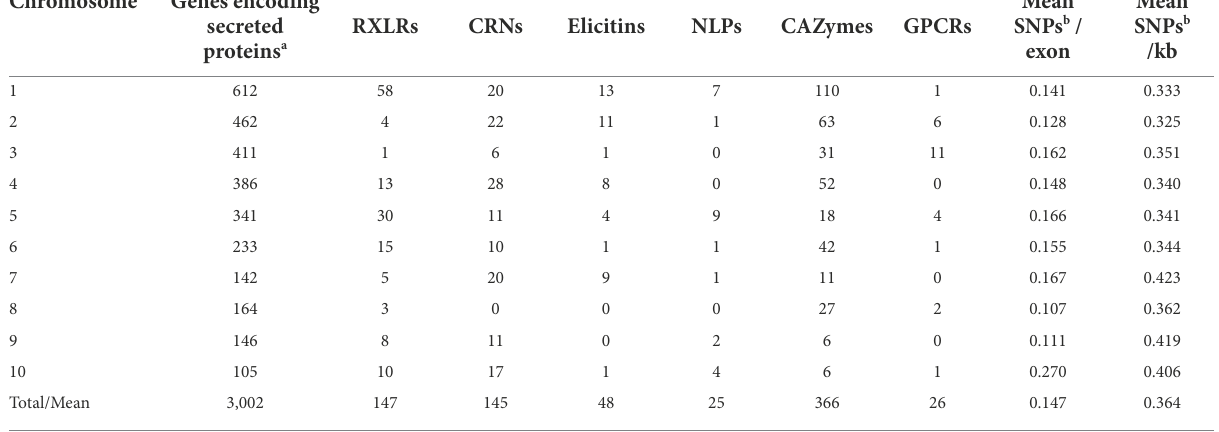
a Proteins with a signal peptide predicted by SignalP v3.0. b SNPs in the genome among 13 other isolates of P. agathidicida (Guo et al., 2020a) compared to P. agathidicida 3770.